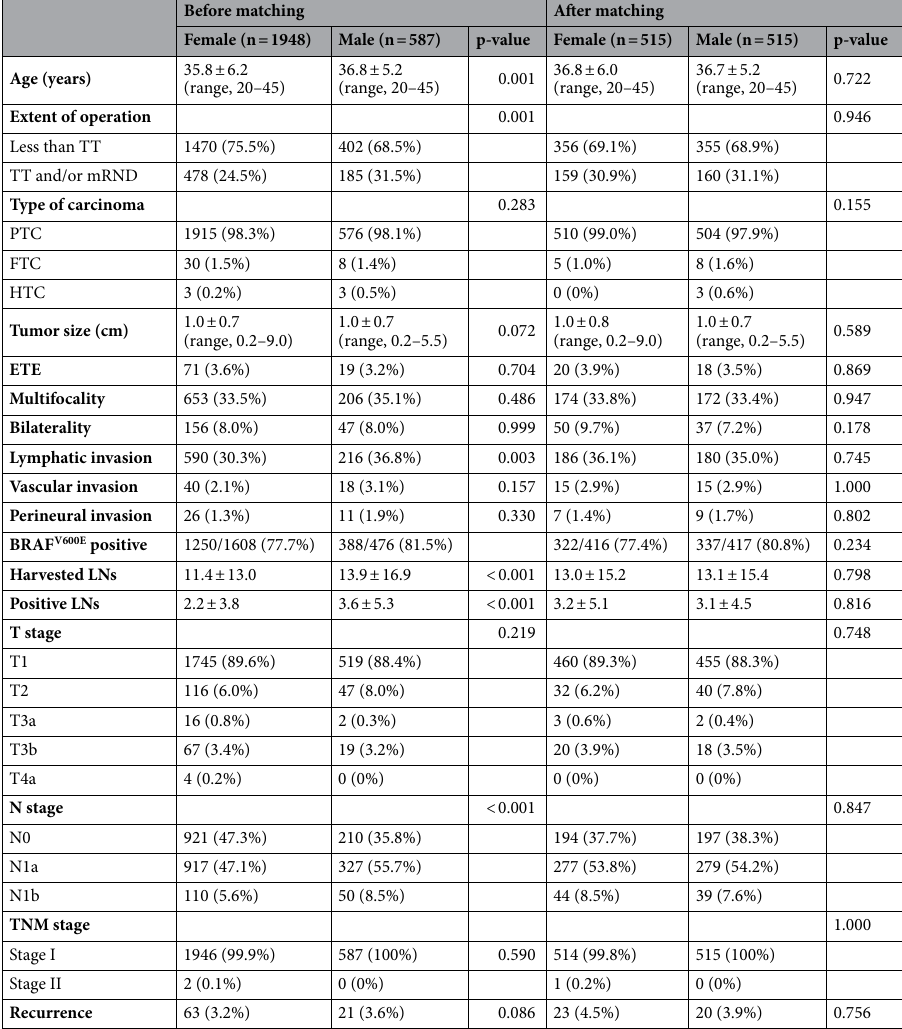
Table 4. Subgroup comparison between female and male participants aged 20–45 years before and after propensity score matching. Data are expressed as patient’s number (%), or mean ± SD. A statistically significant difference was defined as p < 0.05. TT total thyroidectomy, mRND modified radical neck dissection, PTC papillary thyroid carcinoma, FTC follicular thyroid carcinoma, HTC Hürthle cell thyroid carcinoma, ETE extrathyroidal extension, LN lymph node, T tumor, N node, M